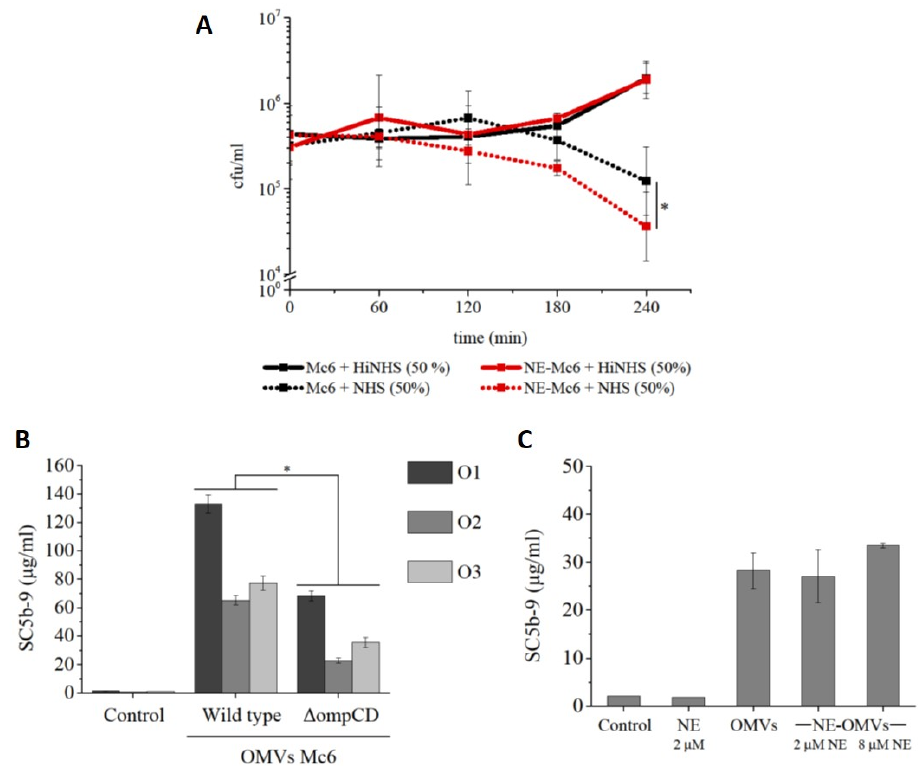
Figure 4. Enzymatic cleavage of surface protein OMP CD by neutrophil elastase (NE) sensitizes M. catarrhalis to human complement action. ( A ) Bactericidal activity of human serum complement (NHS) against WT bacteria treated with NE. Bacteria from log phase were enzymatically digested with 2 µM NE (1 h, 37 °C) before 4 h bactericidal assays were performed. Bacteria untreated with NE and incubated in reaction buffer for 1 h at 37 °C were used as controls. Data are expressed as mean cfu/mL ± SD from two independent experiments performed in triplicate. Statistical analysis was performed by Wald–Wolfowitz test (* p < 0.05); HiNHS-heat inactivated NHS. ( B ) Human serum complement activation in 90% NHS by OMVs from Mc6 WT and its isogenic mutant following 30 min. incubation at 37 °C as determined by ELISA. Data were analyzed using sera from three volunteers (O1–O3) and are expressed as mean SC5b-9 ± SD from two replicates for each serum. Statistical analysis was performed by T test for independent variables (* p < 0.005). ( C ) Activation of human serum complement in 90% NHS by OMVs Mc6 WTe previously cleaved by NE (1 h, 37 °C). Data are expressed as mean SC5b-9 ± SD from two replicates for pooled serum.